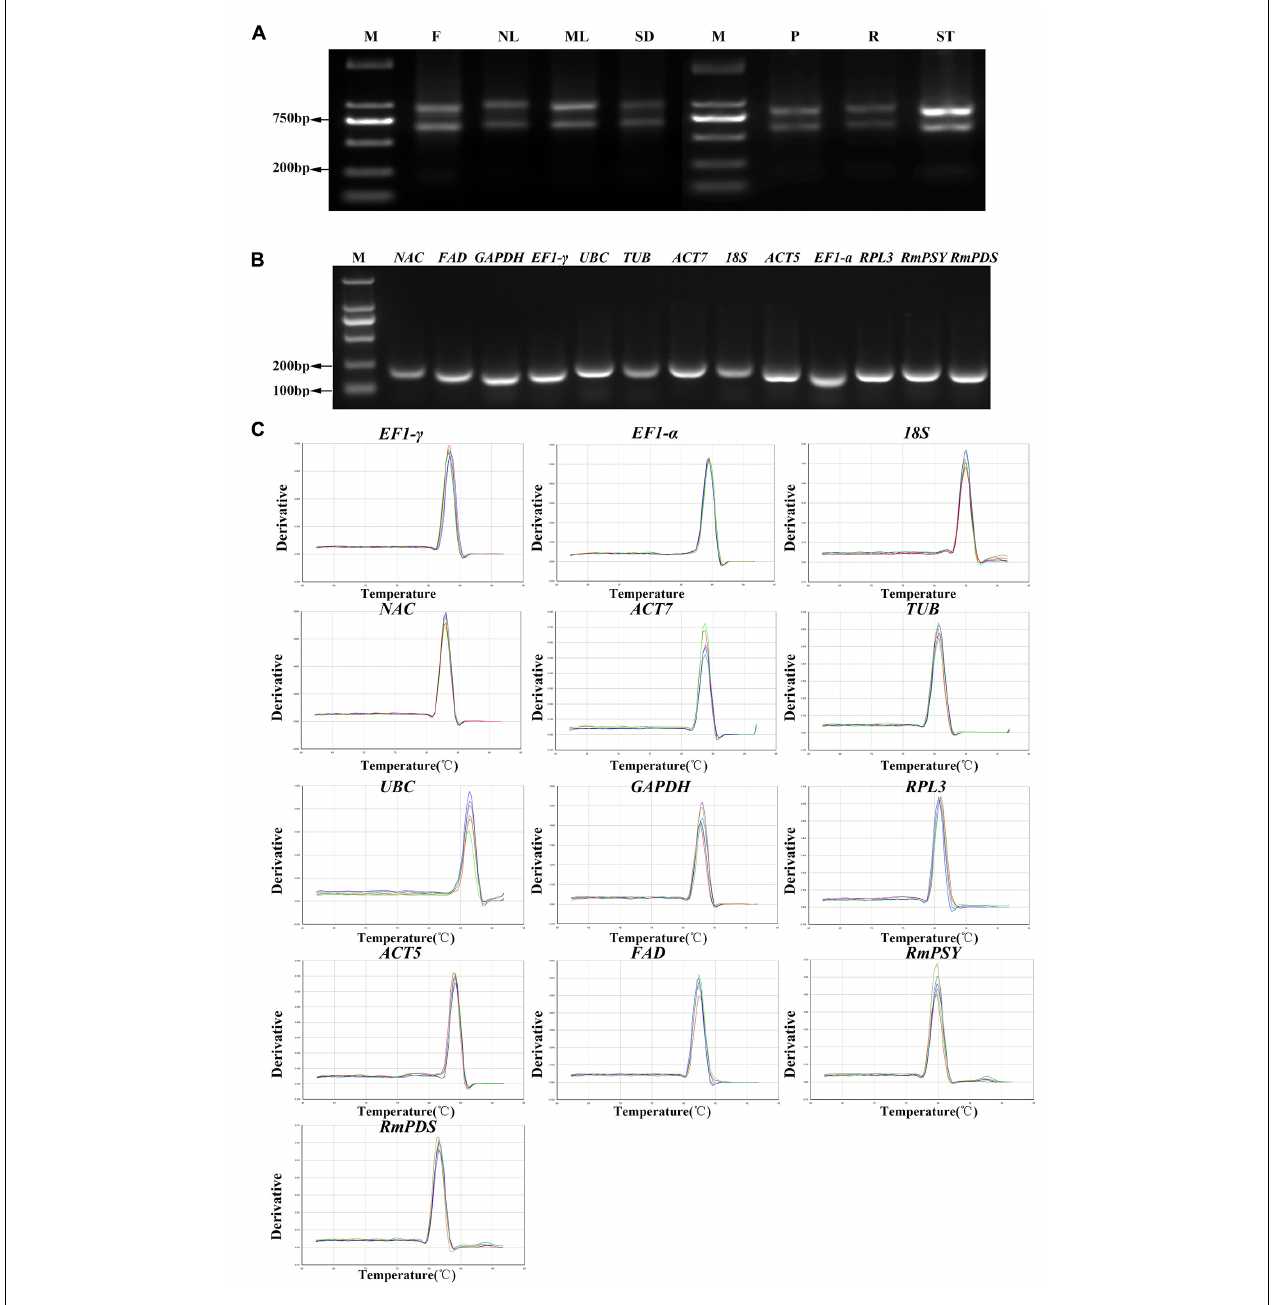
FIGURE 1 | RNA extraction, confirmation of gene specificity and amplicon size. (A) The integrity of RNA samples were determined by electrophoresis on agarose gel. F, flowers; NL, new leaves; ML, mature leaves; SD, seeds; P, petioles; R, roots; ST, stems. (B) Agarose gel showing qRT-PCR products for each gene with the expected size. (C) Melting curves of 13 genes with a single peak. M denotes the 2,000 bp DNA